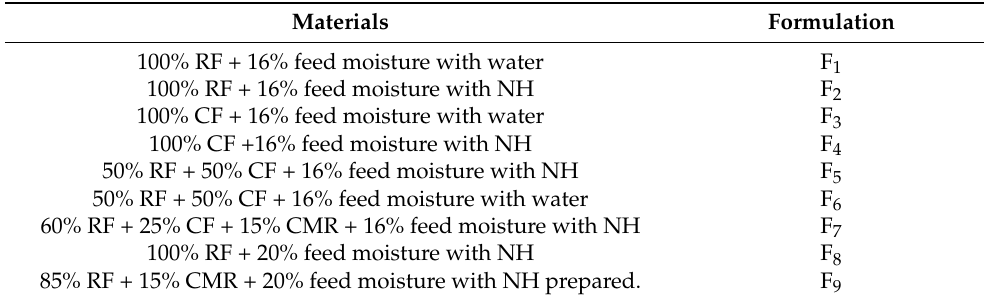
Table 1. Composition of rice flour (RF), corn flour (CF), coconut milk residue (CMR) and neera honey (NH) combinations and their